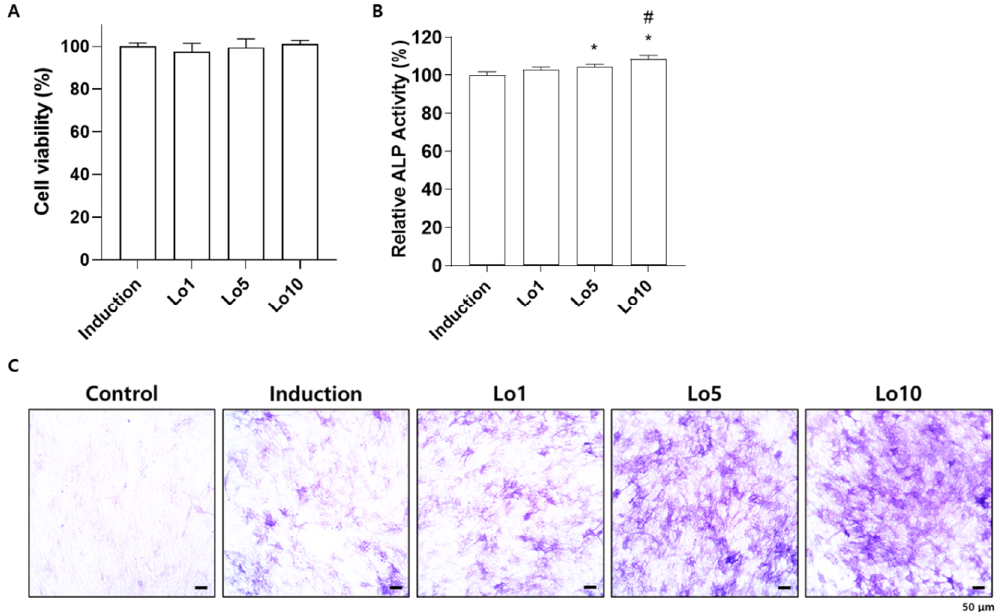
Figure 1. Effects of loganin on the differentiation of mouse preosteoblasts into osteoblasts. MC3T3-E1 cells were incubated in osteoblast induction medium (50 μg/mL of ascorbic acid and 10 mM of β-glycerophosphate) with different concentrations of loganin (1, 5, and 10 μM) for 3 days. ( A ) Cell viability was assessed by Cell Counting Kit 8 (CCK-8) assay. ( B ) Alkaline phosphatase (ALP) activity was determined using p-nitrophenylphosphate as a substrate for ALP. ( C ) ALP-positive cells were visualized under a light microscope. Lo1: loganin 1 μM, Lo5: loganin 5 μM, Lo10: loganin 10 μM. * p < 0.05 vs. induction, # p < 0.05 vs. Lo1 (one-way ANOVA).